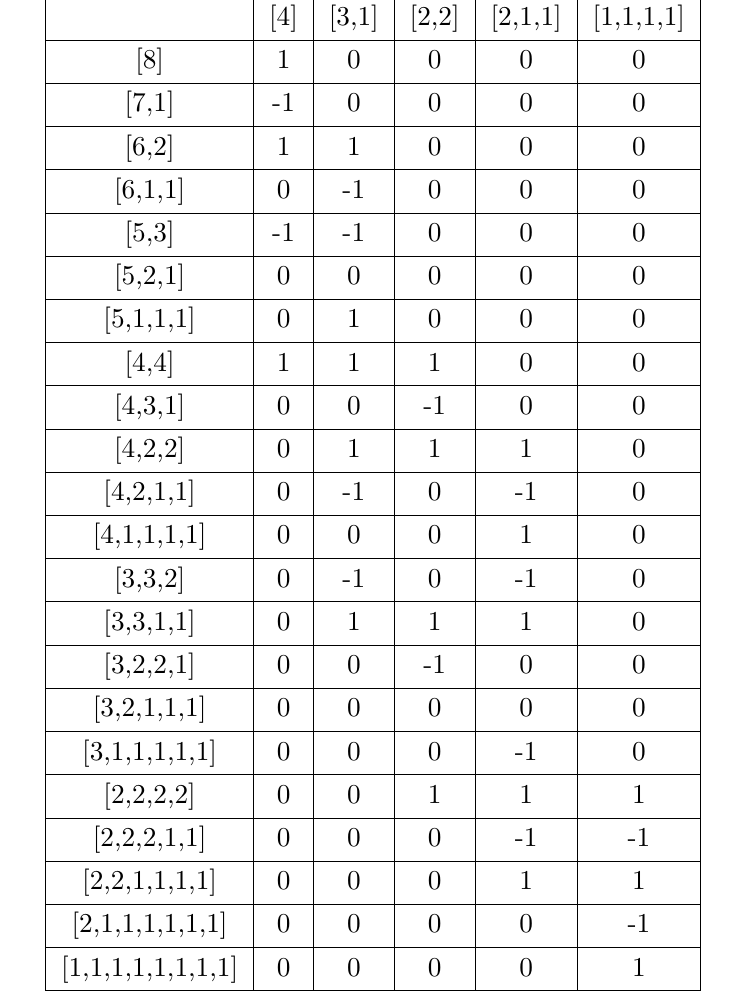
Table 2 . Reduced projection coe(cid:14)cients (cid:22) (cid:11) T at n = 8. The leftmost column indexes R ‘ n while R the top row indexes t ‘ n .The T in (cid:22) (cid:11) T is constructed from t by replacing each individual square in R 2 the Young diagram with a 2 (cid:2) 2